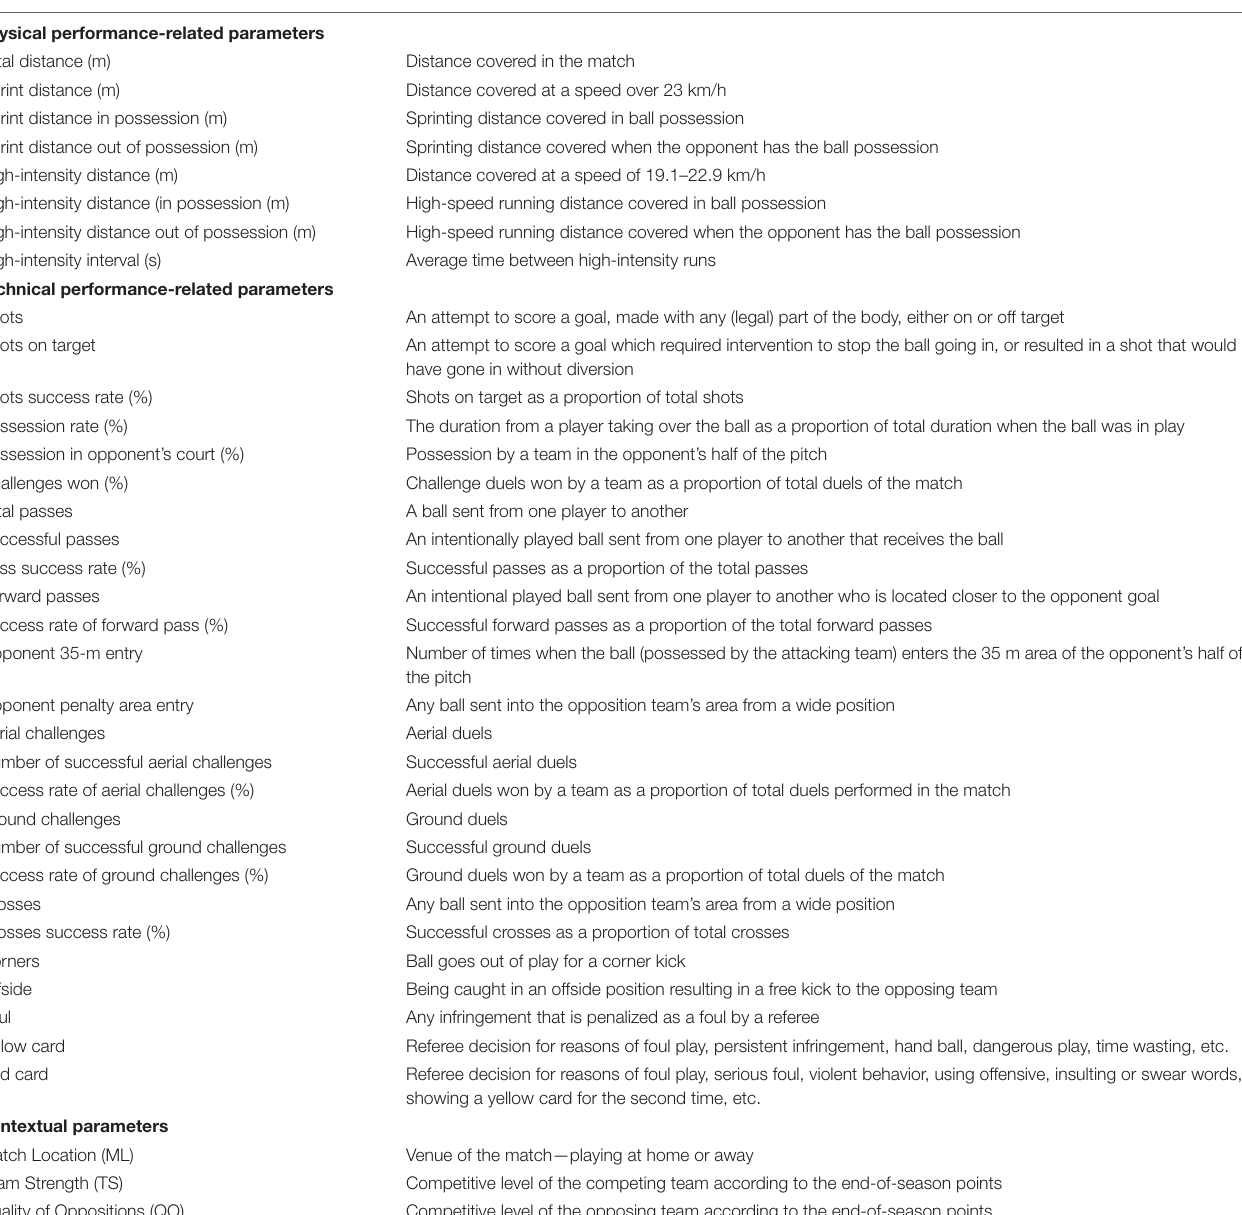
TABLE 1 | Match performance indicators in Chinese Super